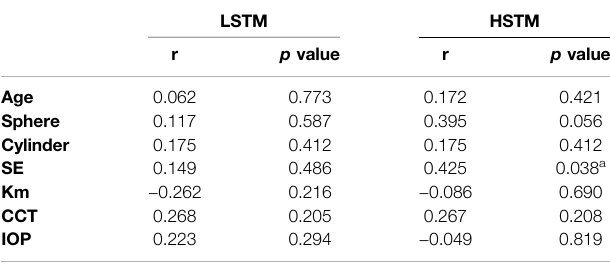
LSTM, low strain tangent modulus; HSTM, high strain tangent modulus; SE, spherical equivalent; Km, mean keratometry; CCT, central corneal thickness; IOP, intraocular pressure. a p < 0.05.